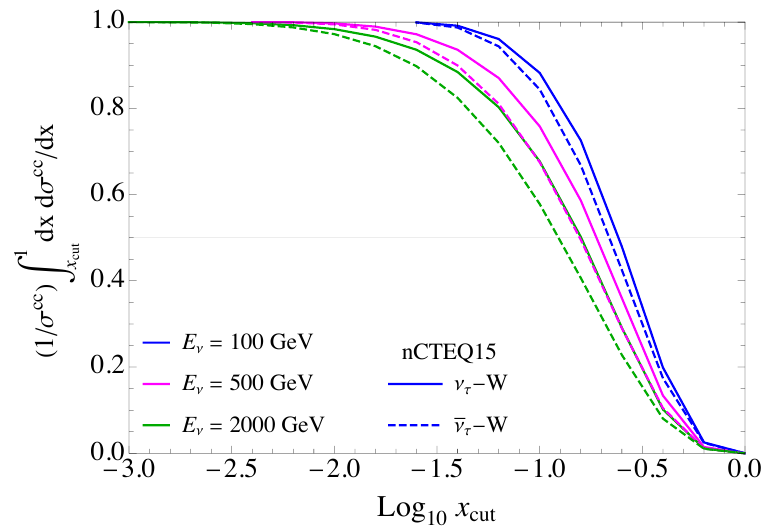
Figure 16. For selected tau neutrino energies, the fractions of the charged current neutrino- tungsten cross section as a function of x min = x cut are presented for tau neutrinos and